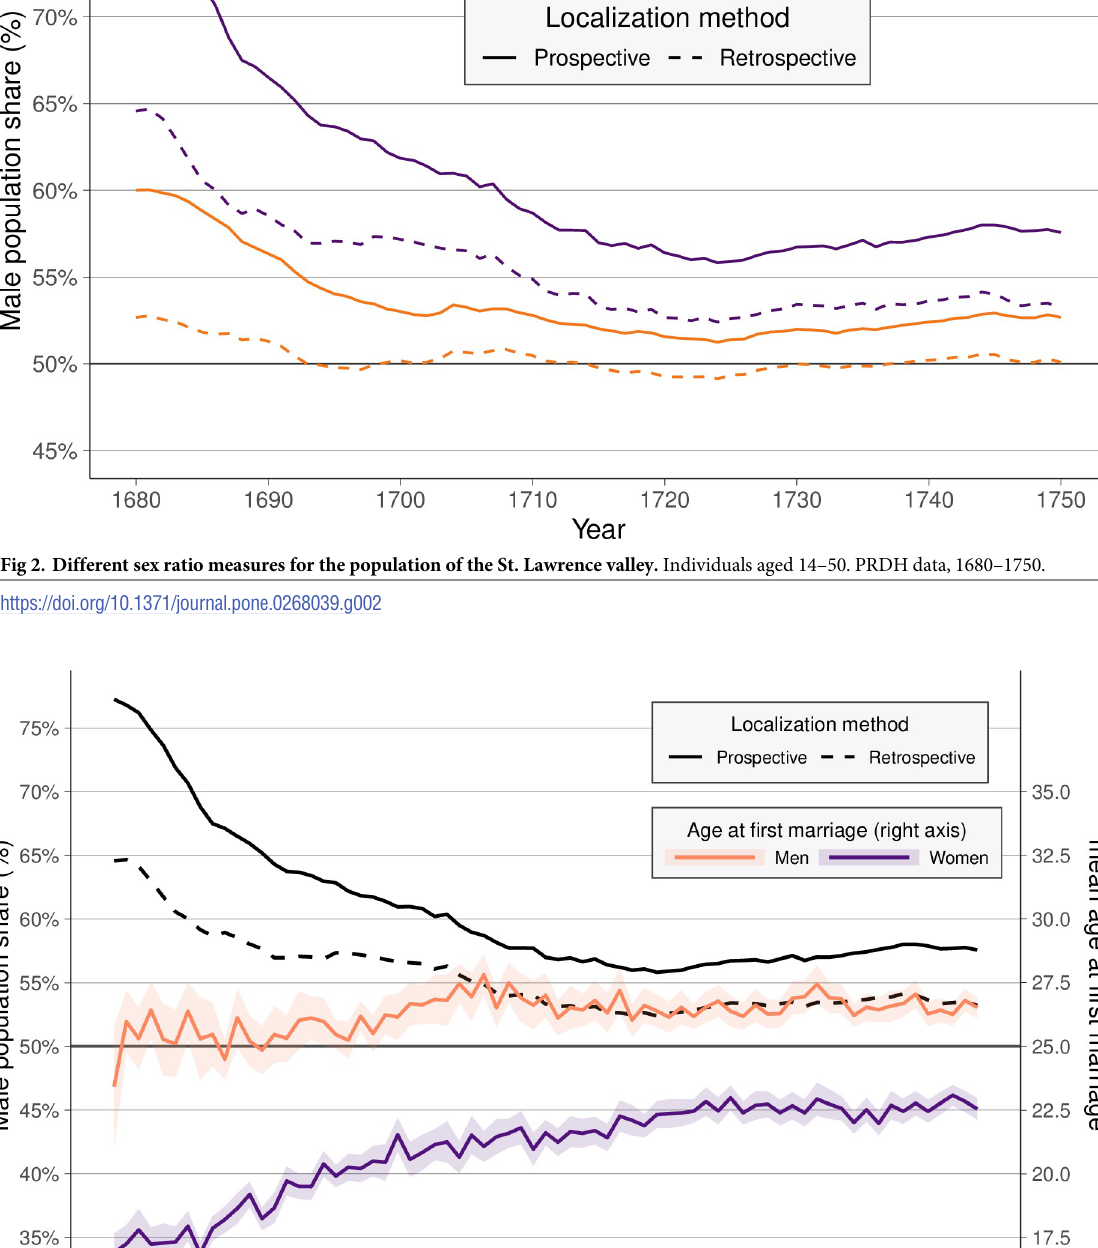
PLOS ONE | https://doi.org/10.1371/journal.pone.0268039 June 8,